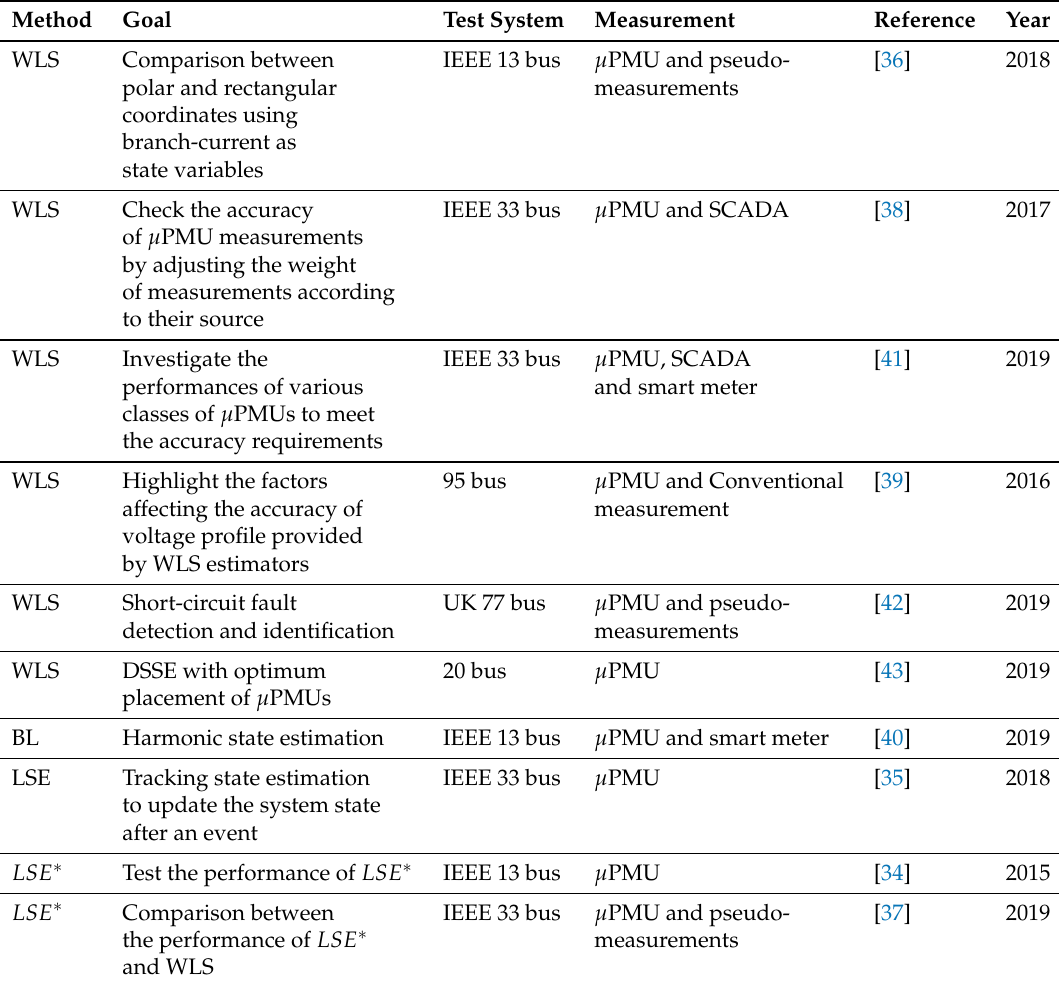
Table 3. State estimation algorithms for distribution networks. WLS: Weighted Least Squares; BS: Bayesian Learning; LSE: Least Squares Estimation; LSE ∗ : Linear State